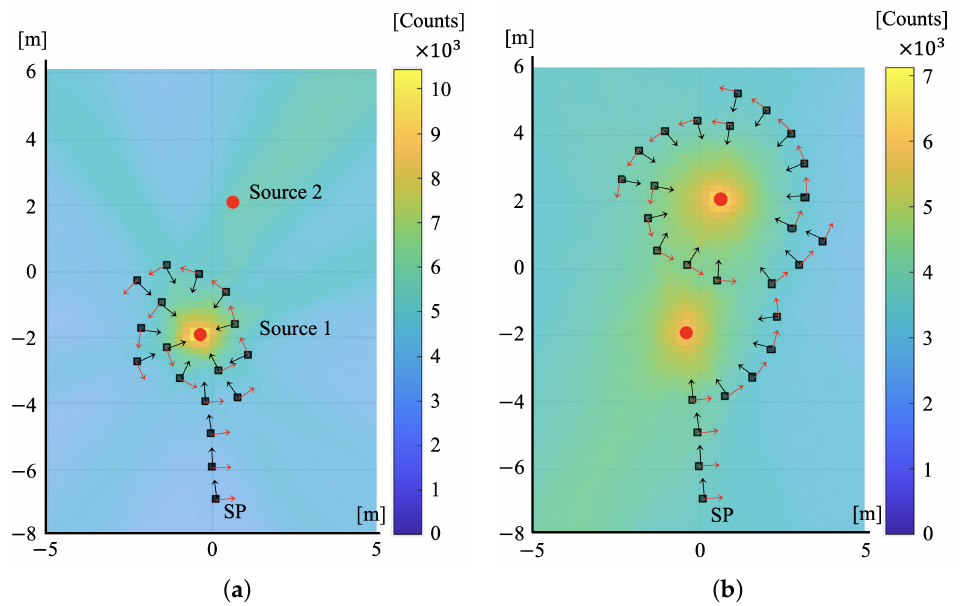
Figure 14. Simulation results of dispersed multiple radiation sources: ( a ) The results obtained when the threshold was set to 5000 ( b ) The results obtained when the threshold was set as 2500. It was confirmed that the measurement path significantly depends on the setting of the threshold required to switch the principal component